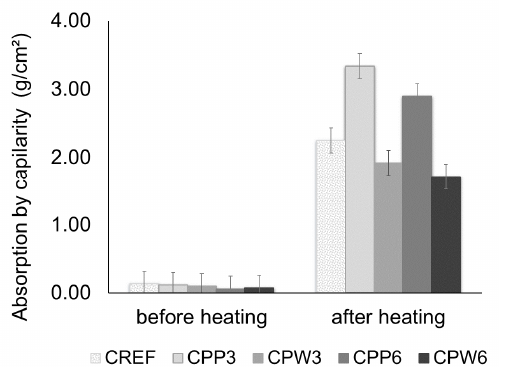
Figure 9. Absorption by capillarity before and after heating.